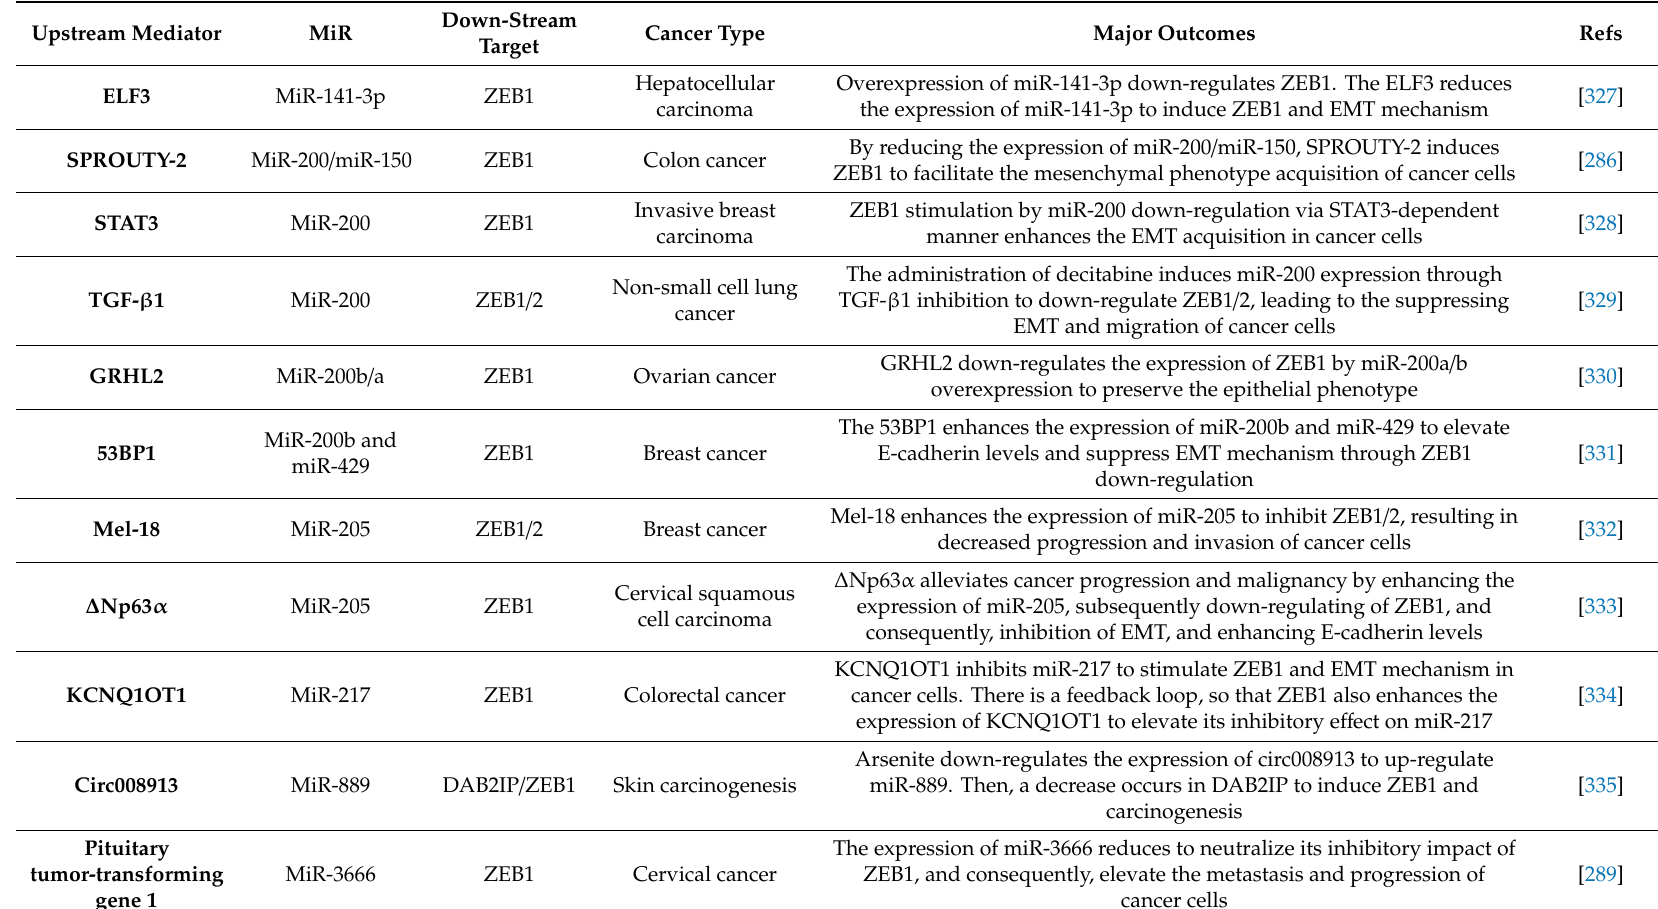
Table 3. miR / ZEB1 regulation by various molecular pathways in di ff erent